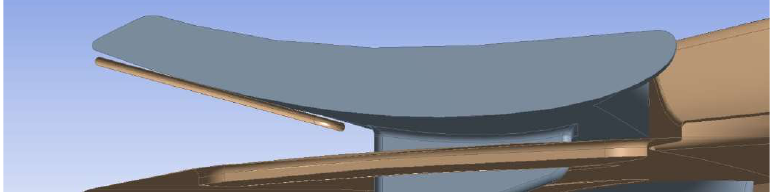
Figure 9. A view of the retracted spoiler, with the plate just below it. For each spoiler angle, the plate is also rotated so that flow is properly directed under the spoiler. Examples of spoiler and booster plate positions are presented in Figure 10.